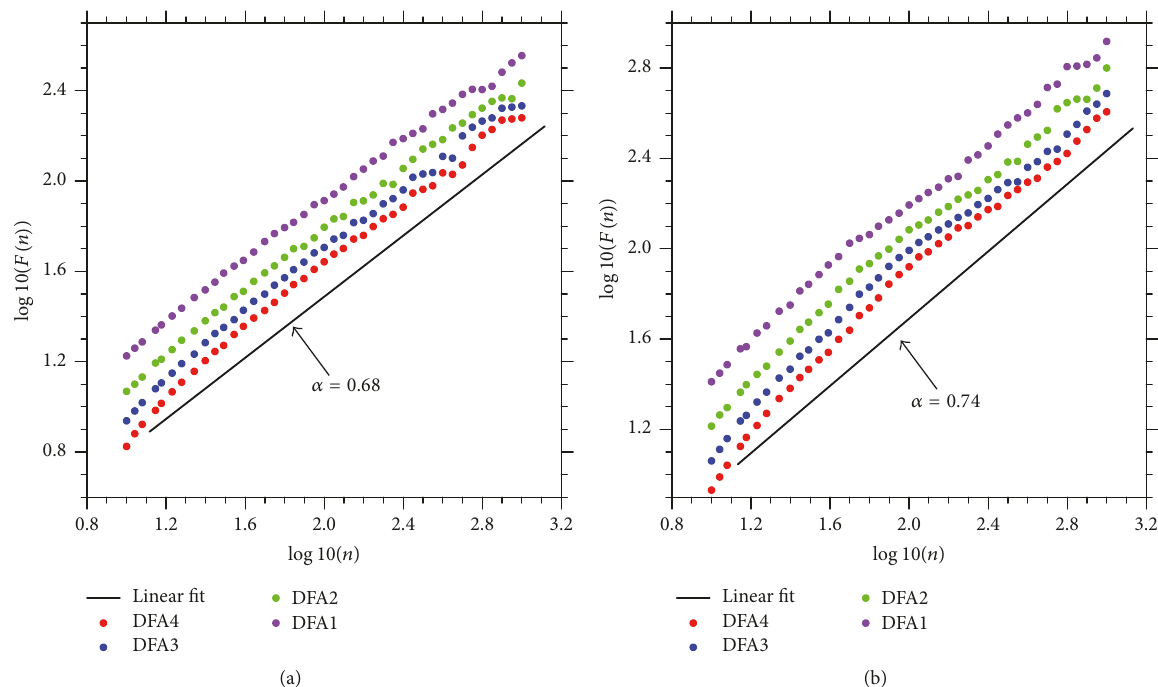
Figure 2: The double log plots of power-law relationship between the detrended variability 𝐹(𝑛) and the time scale 𝑛 for the two grid points (95 ∘ E, 35 ∘ N) and (97.5 ∘ E, 12.5 ∘ N) using DFA1–DFA4. The black solid line represents linear fit. (a) is for the grid point (95 ∘ E, 35 ∘ N) and (b) is for the grid point (97.5 ∘ E, 12.5 ∘